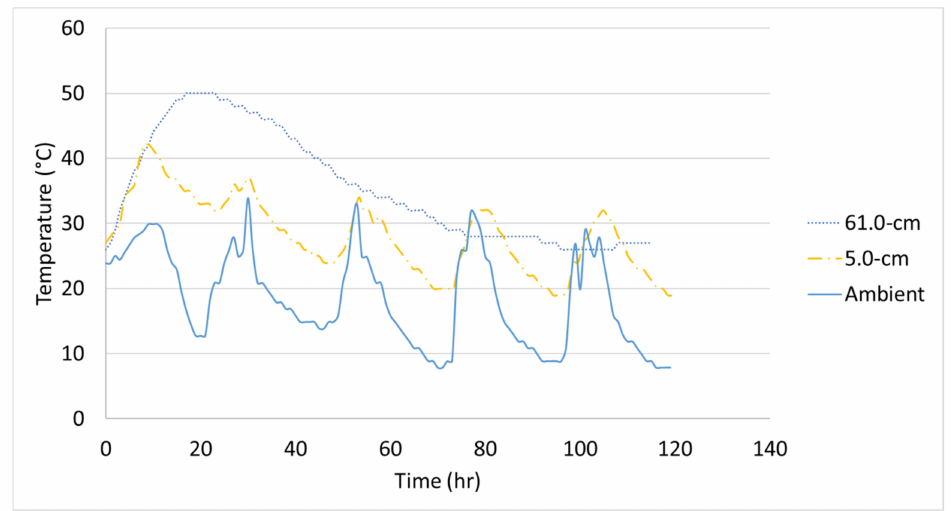
Figure 6. Temperature-time history of Batch 1’s 1.2-m (4-ft)